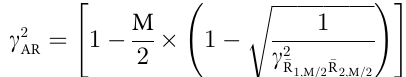
ffiffiffiffiffiffiffiffiffiffiffiffiffiffiffiffiffiffiffiffi 1 g 2 � R 2 ; � R 1 ; M = 2 M =